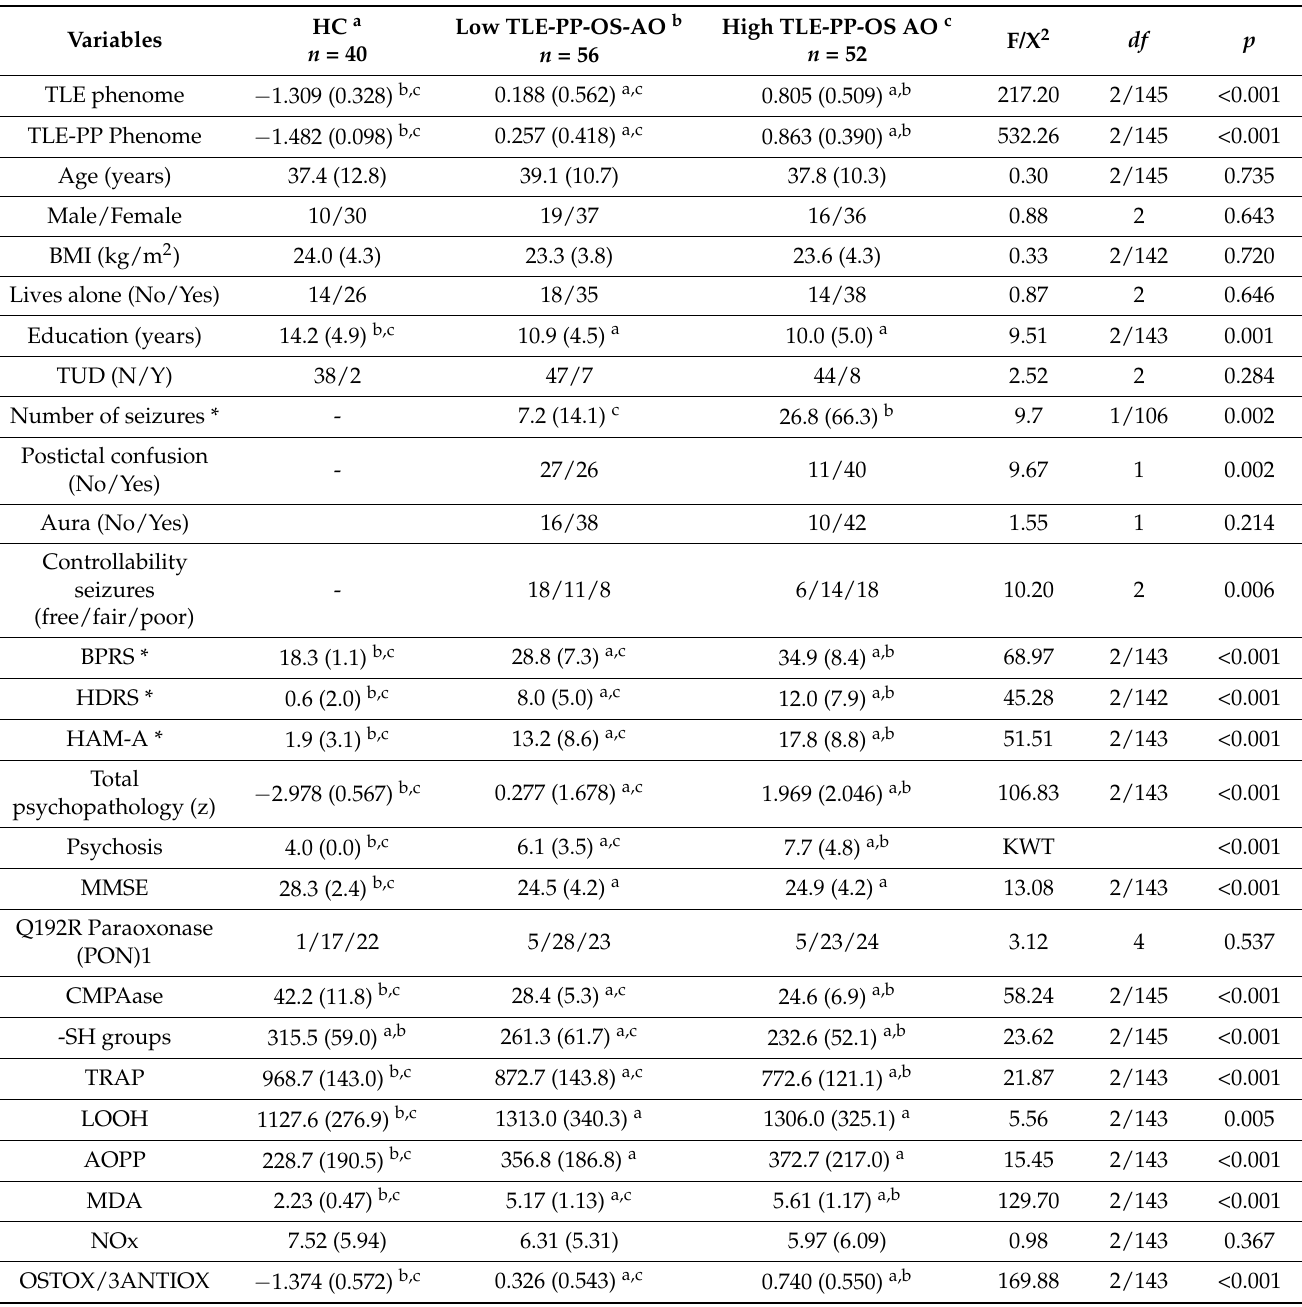
Table 3. Differences in socio-demographic, clinical and biomarker data between healthy controls (HC) and patients divided according to the factor analysis score (FA3) shown in Table 1 into those with low and higher pathway phenotype (TLE-PP-OS-AO)